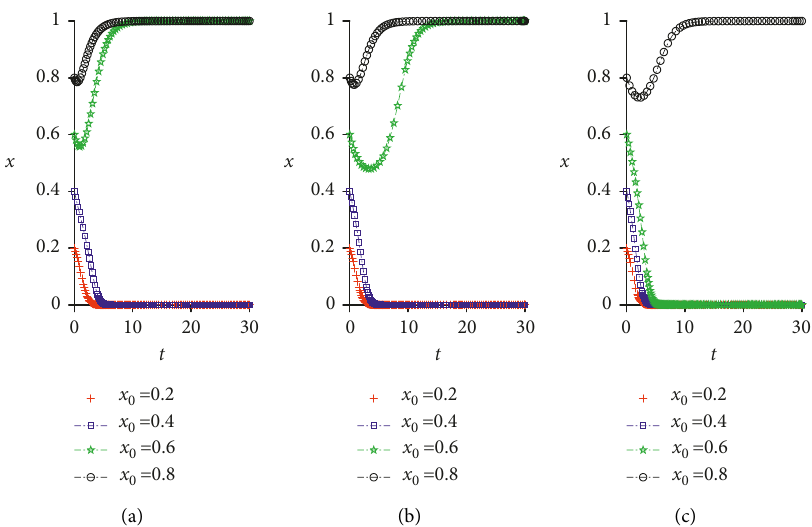
Figure 5: Impact of β on system evolution. Comparing (a), (b), and (c), as β (client’s spillover coefficient) increases, the probability of the system evolving to the ideal state decreases. (a) β